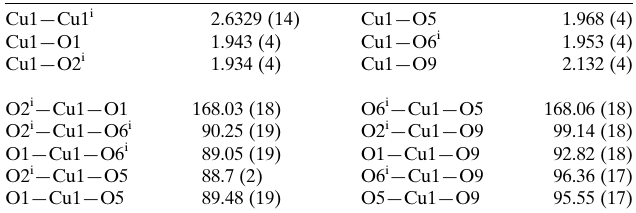
Table 1 Selected geometric parameters (A˚ , (cid:3) ).